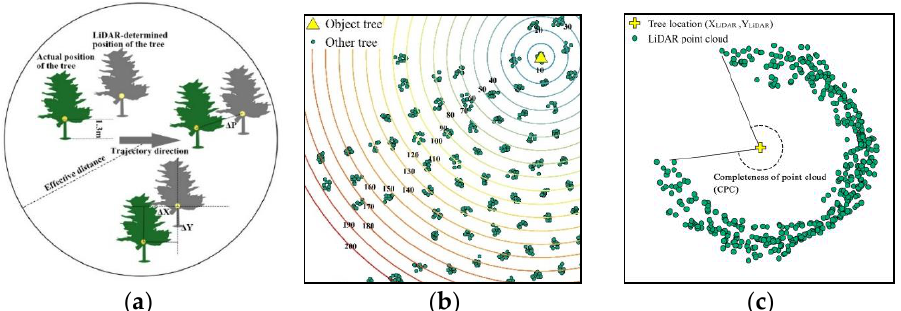
Figure 2. Schematic illustrations of indicators considered in this study. ( a ) Relative position error ∆ P and deviation in the east and north offsets: ∆ X, ∆ Y. ( b ) Distance interval from any tree to other trees, i.e., search radius for calculating the relative distance error. The number in the figure is the radius of the search range with the target tree as the center (m). ( c ) Completeness of the stem point cloud (CPC, °).